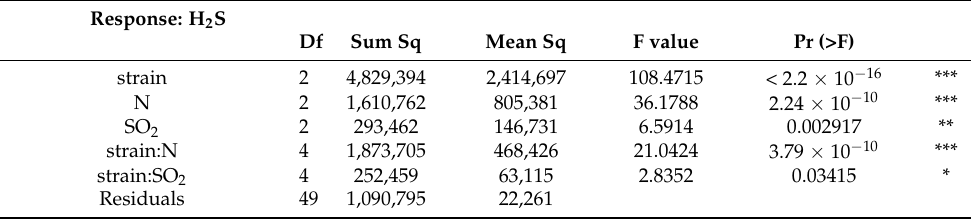
Table 2. Analysis of variance